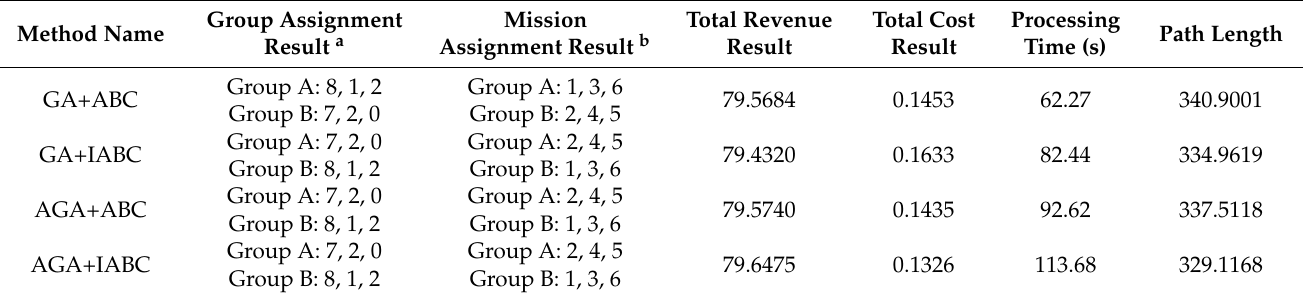
Table 19. Results of multi-UAV optimal mission assignment and path planning using different optimization methods.